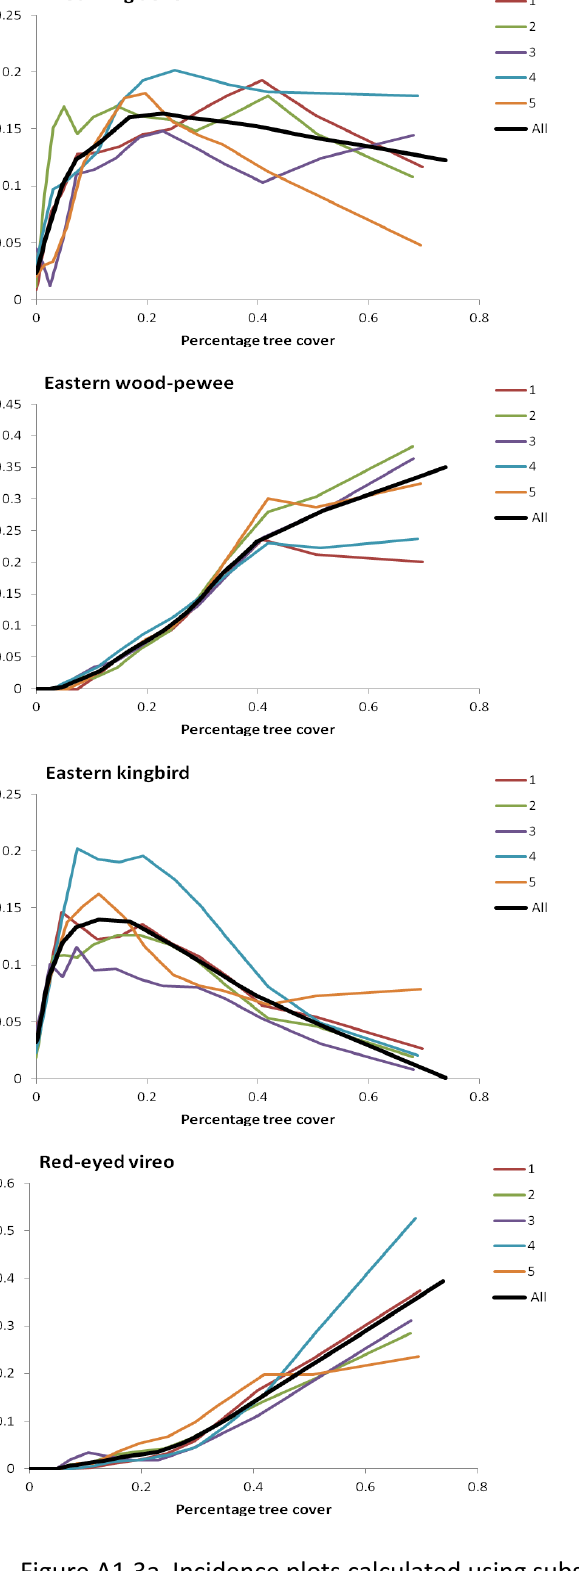
Figure A1.3a Incidence plots calculated using subsamples of the data and all data for 8 of 16